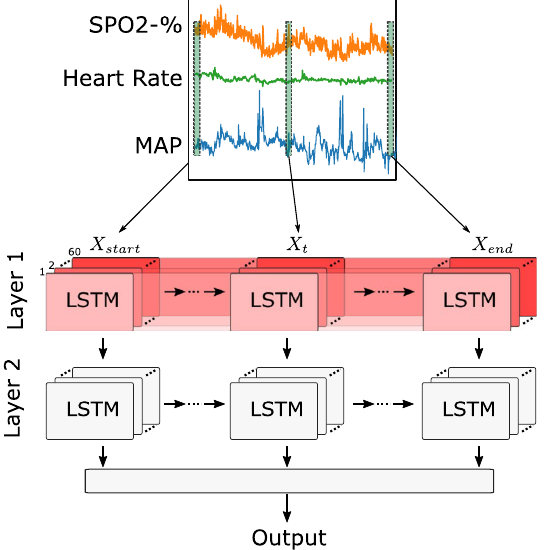
Figure 6. The architecture of the LSTM network. A window of physiological data containing MAP, HR, and SPO2% recordings is processed through 2 LSTM layers with the output of the last LSTM layer being merged in a final layer to make a binary prediction. LSTM units in the first layer are shown with different colors (unit 1: lighter red through unit 60: darker